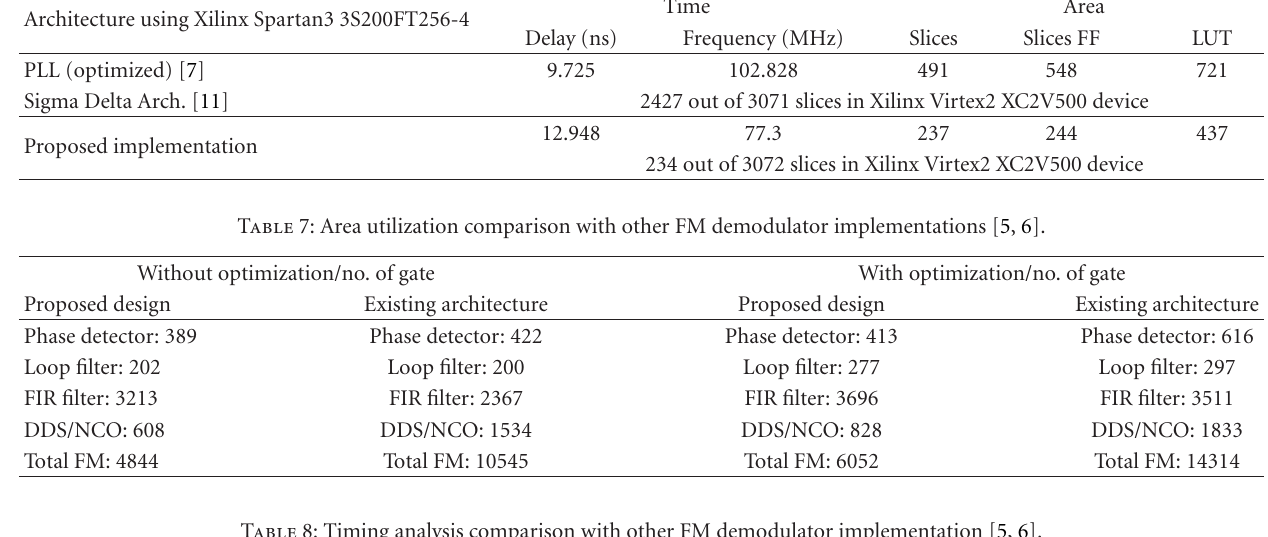
Table 8: Timing analysis comparison with other FM demodulator implementation [5, 6]. Without optimization With optimization